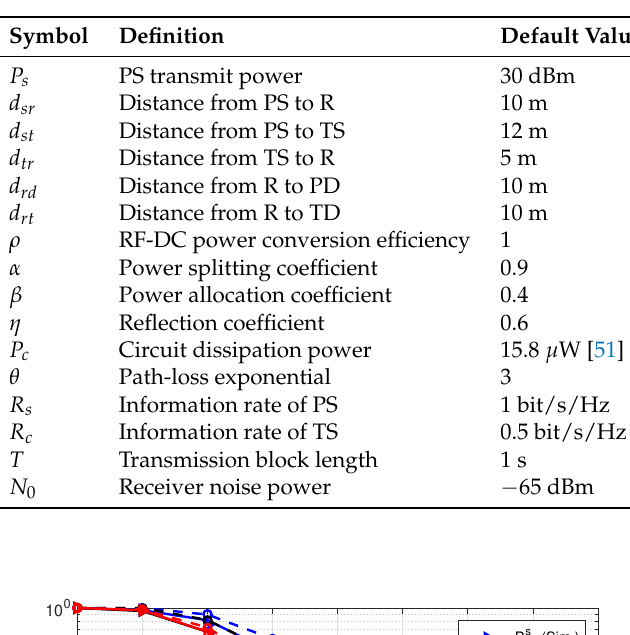
Table 1. Parameters in simulations.